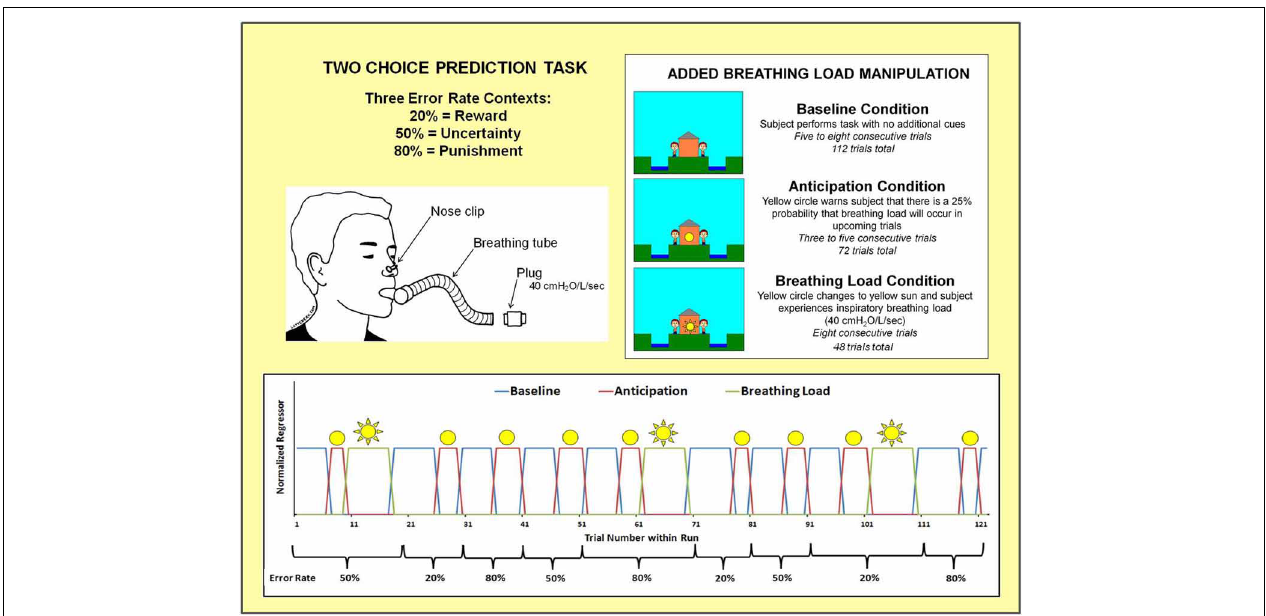
FIGURE 3 | Illustration of two choice prediction task with added breathing load manipulation. Unbeknownst to subjects, the task was divided into three blocks of trials with differing reinforcement schedules: 20,